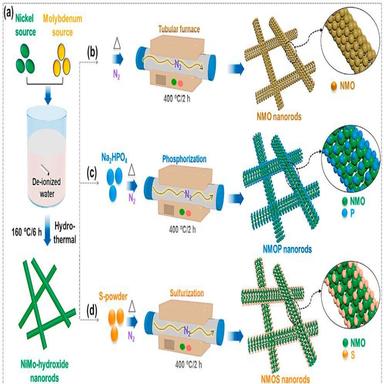
Schematic diagram illustrating the preparation of 1D (a) NiMO-hydroxide NRs, (b) NMO NRs, (c) NMOP NRs, and (d) NMOS NRs.